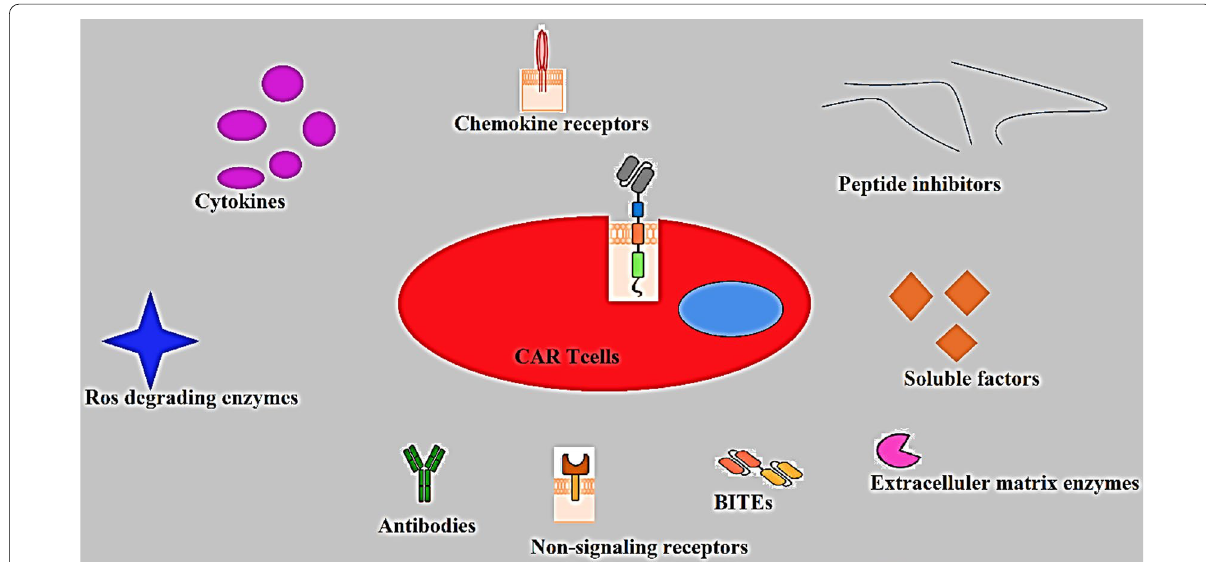
Fig. 3 Approaches for enhancing chimeric antigen receptor with cancer interactions. Through such a range of strategies, chimeric antigen receptor were designed to be used, counter, or avoid tumor-driven immunosuppressive mediators and